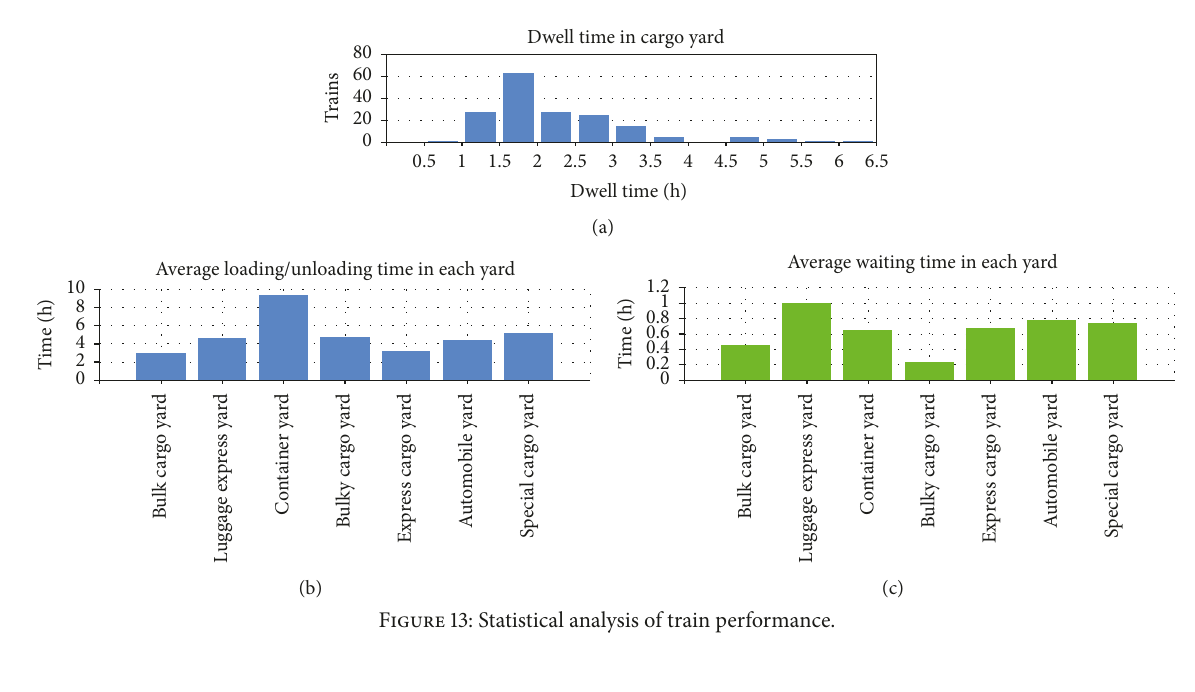
Figure 12: Time information of the train moving process.